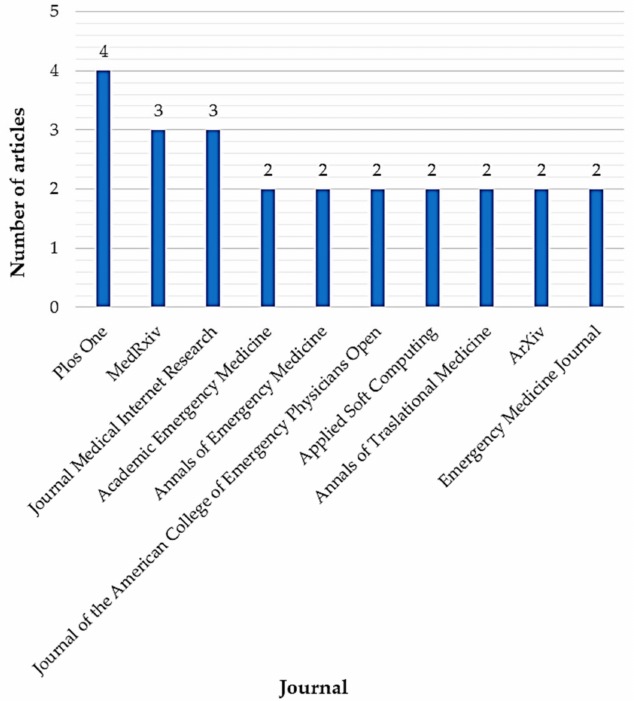
Figure 7. The journals most contributing to the evidence